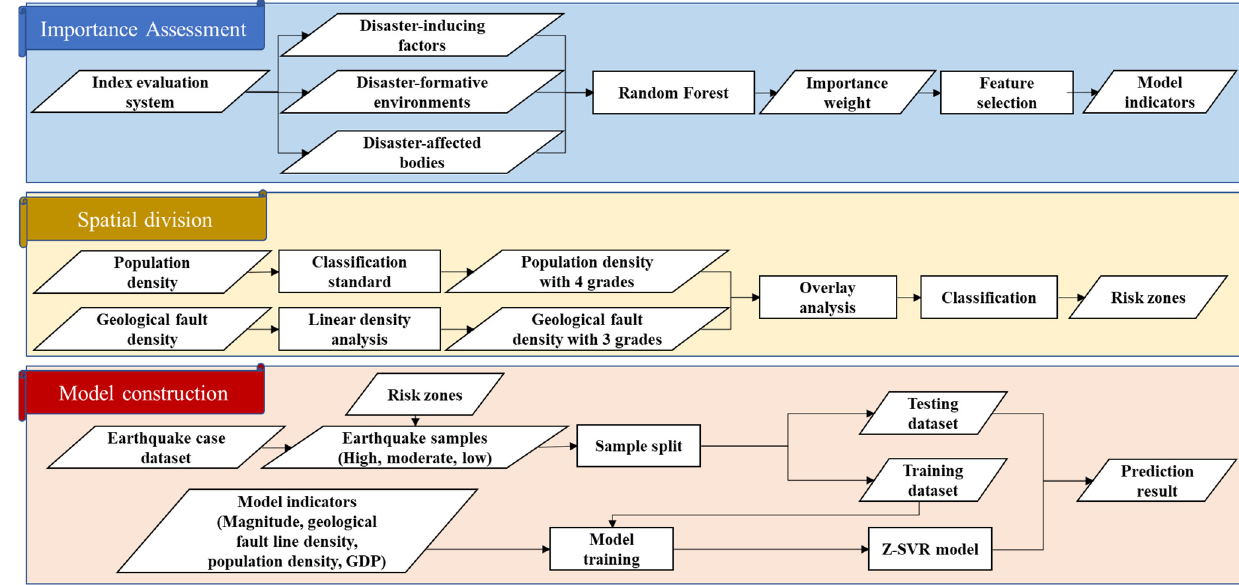
Figure 5. Framework of the Z-SVR model.